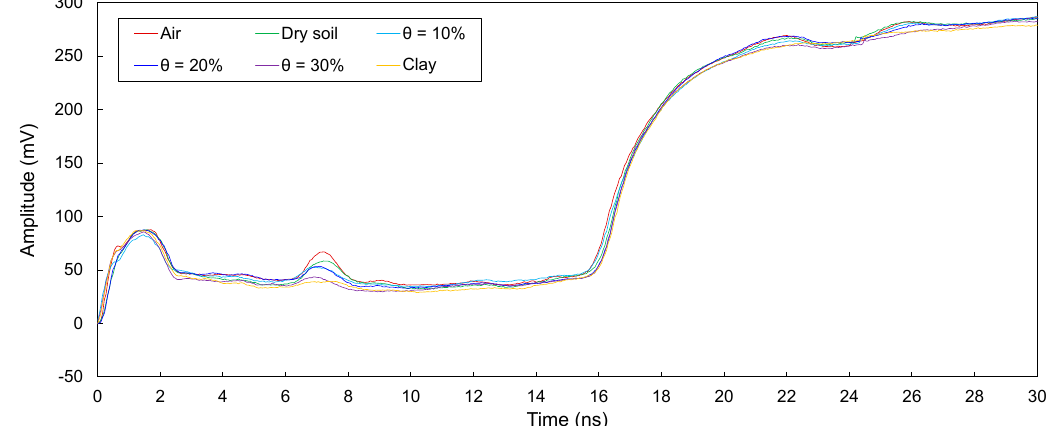
Figure 9. Measured signals for D2 with the defect filled with different materials of air; dry sand; wet sands with θ = 10%, 20%, and 30%; and clay.